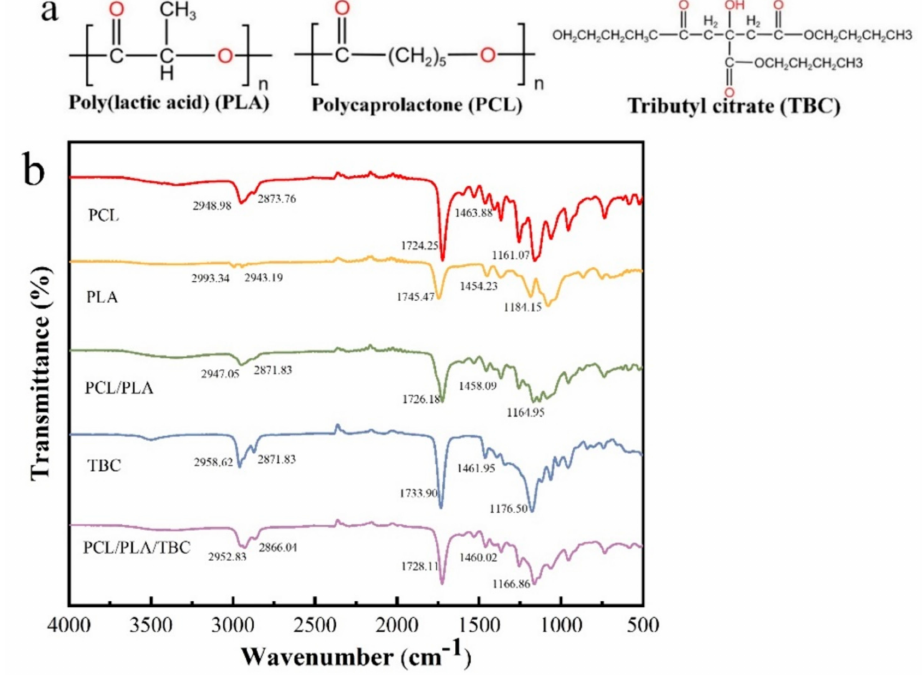
Figure 2. ( a ) Chemical formulae of the main materials. ( b ) FTIR spectra of samples with the composi- tion of PCL, PLA, PCL/PLA, TBC, and